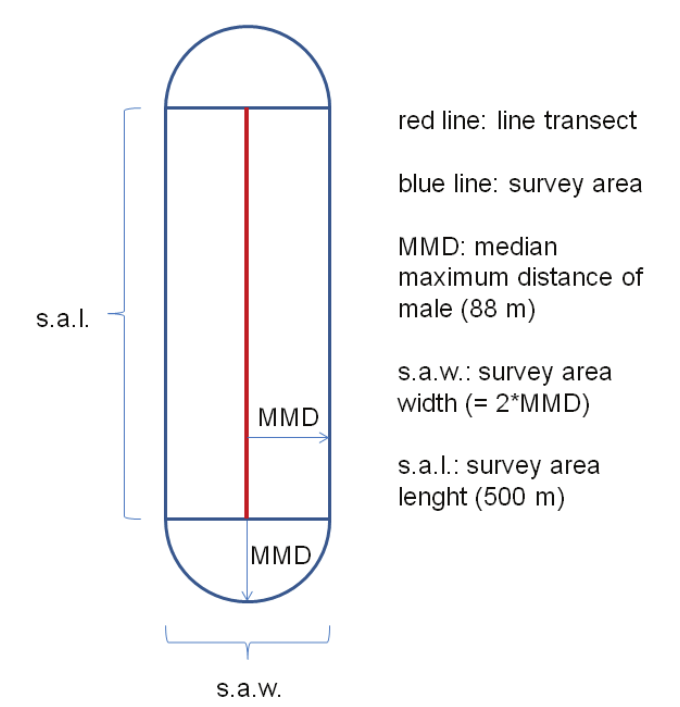
Figure 16. Graphic layout of a transect through the survey areas to show the spatial validity of the ob- servations. MMD is the median of the maximum distance covered by a male in a single flight from the transect, as observed during the radiotelemetric fieldwork.